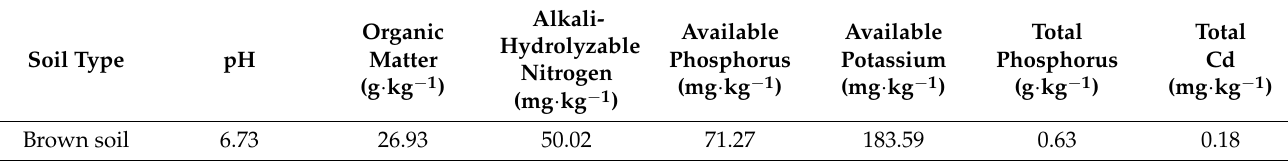
Table 1. Physical and chemical properties of the tested soil.